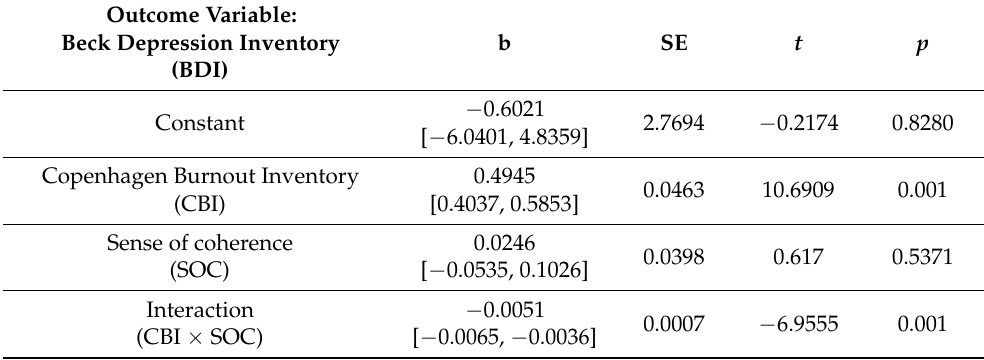
Table 5. Moderation analysis: SOC as a negative moderator of the relationship between CBI and BDI. Outcome